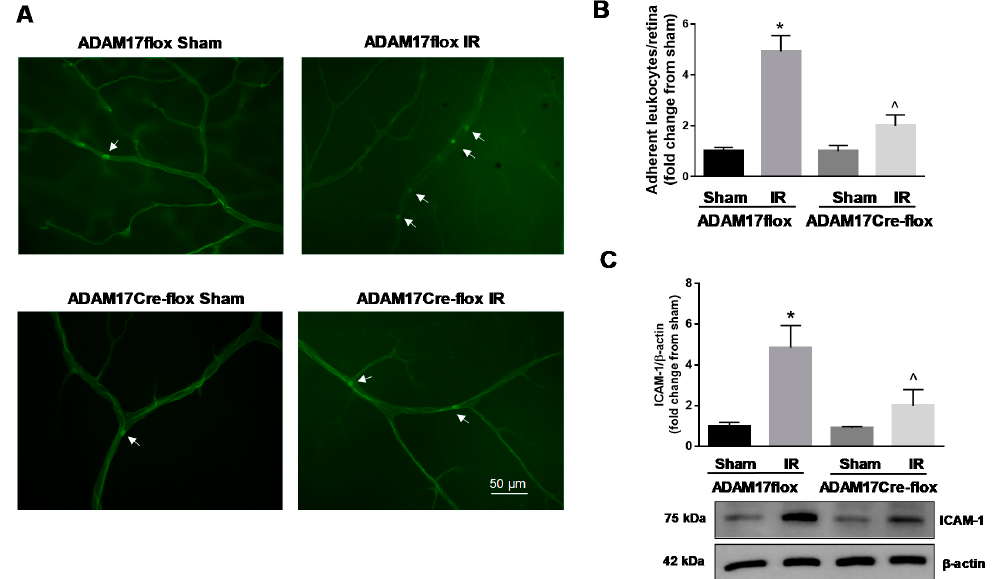
Figure 7. IR-induced retinal leukostasis is reduced in mice with conditional inactivation of ADAM17 in vascular endothelium. ( A ) Representative images of flat-mounted retinas from control ADAM17flox and ADAM17Cre-flox mice 48 h after reperfusion stained with ConA to identify leukocytes adherent to retinal microvessels (white arrows). Scale bar, 50µm. ( B ) Quantification of adherent leukocytes. Data are expressed as adherent leukocytes per retina and presented as fold change of corresponding controls. Values are mean ± SE. Results are presented as fold of change of sham. * p < 0.001 vs. corresponding sham; ^ p < 0.01 vs. ADAM17flox IR; n = 5 in each group. ( C ) Representative Western blots and densitometric analysis of ICAM-1 evaluated 48 h after reperfusion. Actin was used as an internal control. Values are mean ± SE. Results are presented as fold change from sham. * p < 0.01 vs. corresponding sham; ^ p < 0.05 vs. ADAM17flox IR; n = 5 in each group. 2.9. Knockdown of Endothelial ADAM17 Reduces Cleavage of p75NTR in the Ischemic Retina ADAM17-mediated proteolytic cleavage of extracellular domain of p75 neurotrophin receptor (p75NTR) can result in generation of a pro-apoptotic intracellular domain, p75ICD, in a process called regulated intramembrane proteolysis [40,41]. To assess whether this ADAM17-regulated mechanism could contribute to retinal IR-induced cellular degeneration, we assessed cleavage of p75NTR in the IR-injured retinas of control mice and mice lacking expression of ADAM17. Our Western blotting analysis using p75NTR cytoplasmic domain-specific antibody showed that IR (6 h) caused a significant upregulation of p75NTR in control ADAM17flox mice (Figure 8A,B). Consistent with